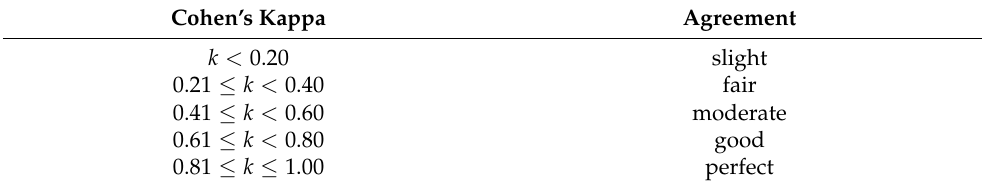
Table 4. Cohen’s Kappa vs